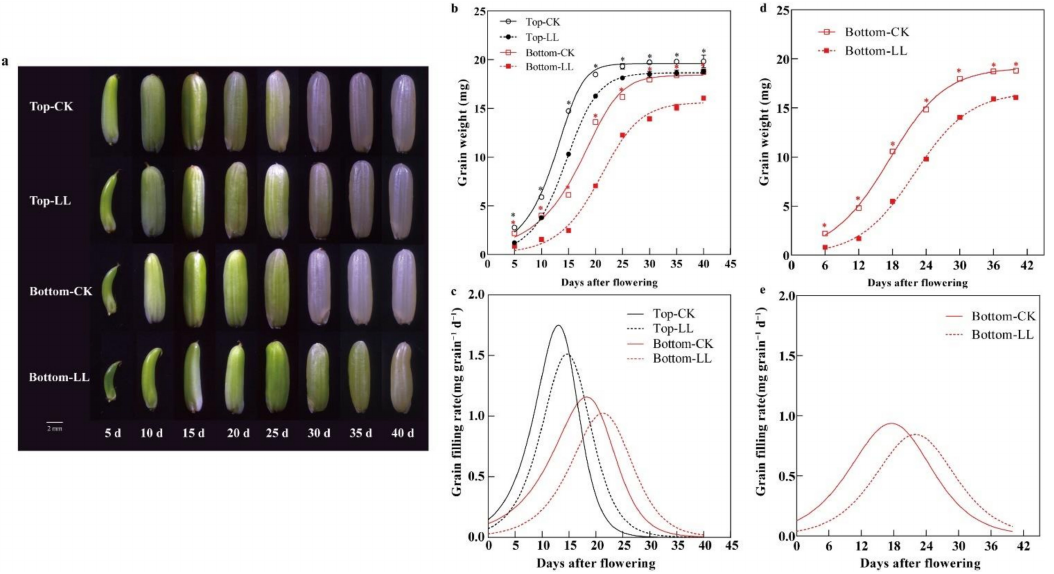
Figure 4. Growth and development of rice grain and grain filling under LL in 2020 ( a – c ) and 2021 ( d , e ). Top, top panicle part; bottom, bottom panicle part; CK, full sunlight control; LL, low light stress. * p <